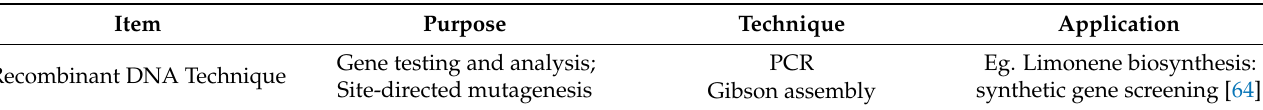
Table 3. Synthetic biotechniques in the biosynthesis of botanical